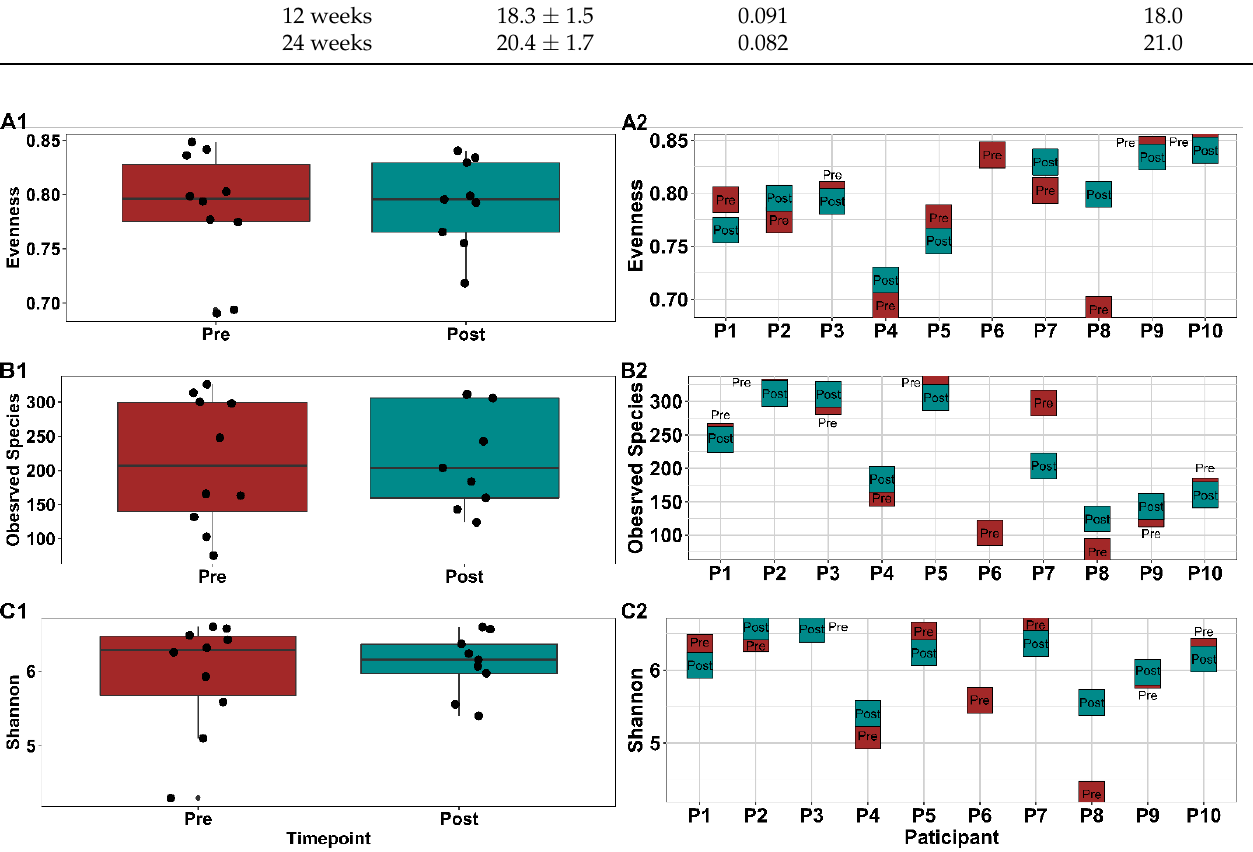
Figure 3. Gut microbiota alpha diversity indices in Alberta Cancer Exercise (ACE) participants.